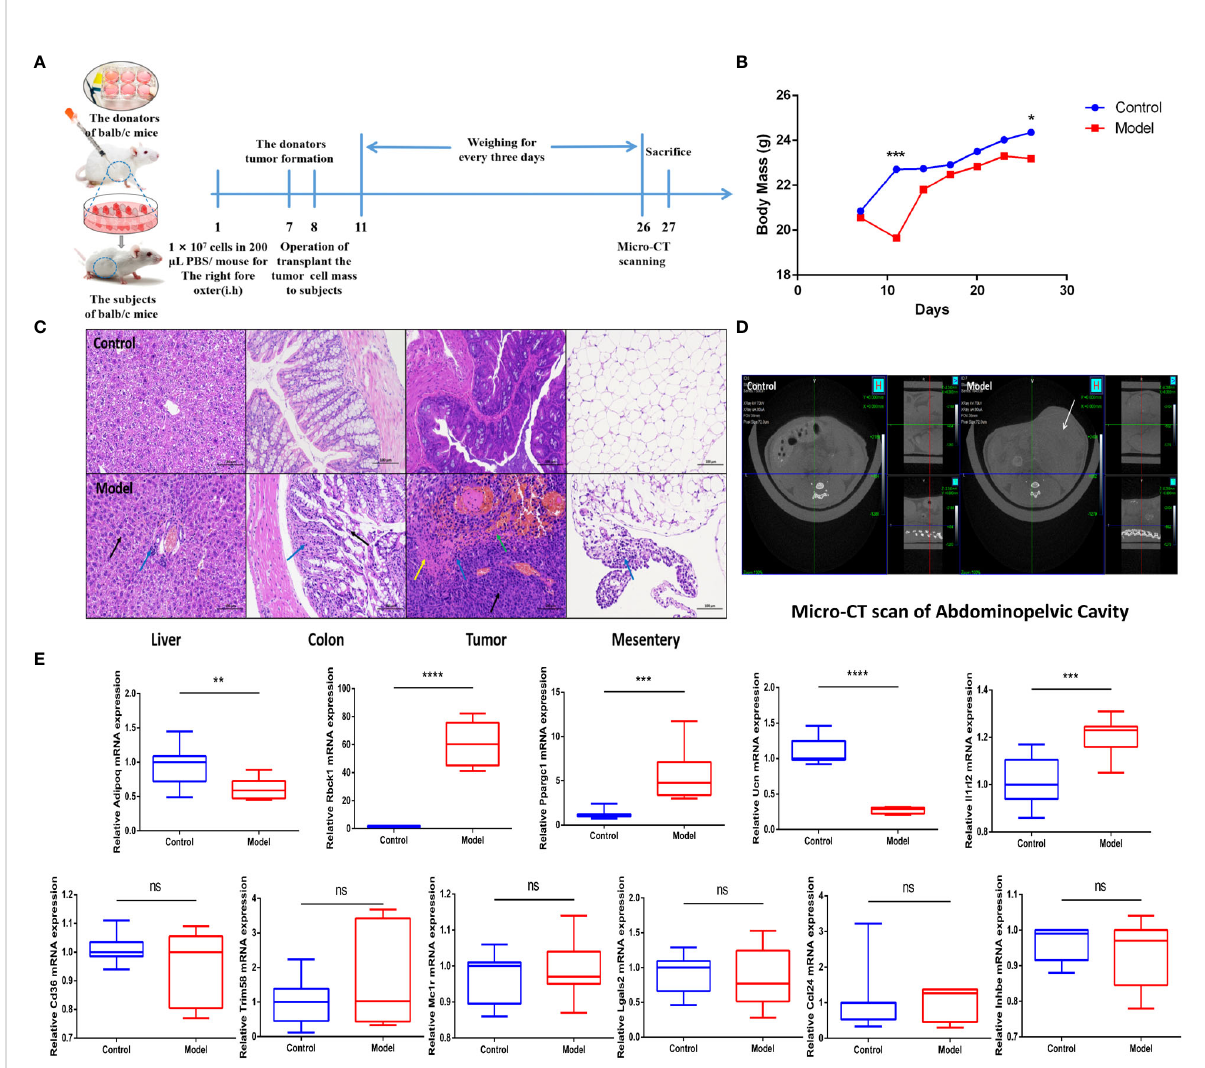
FIGURE 5 IRGPI gene expression situation in the identi fi ed murine CRC model. (A) Experimental scheme to establish the murine conlon transplant CRC metastasis model. (B) Curve of murine body mass change trends ( n = 10, * p < 0.05, *** p < 0.001). (C) In fl ammatory changes within liver, colon, tumor, and mesentery were measured by H&E staining (scale bar = 100 m m; the blue arrow points to the in fl ammatory cell in fi ltration; the black arrow points to the cellular damage; the yellow arrow points to the tumor cells nuclear abnormalities and cytoplasm eosinophilic; the green arrow points to the necrosis and hemorrhage). (D) Micro-CT scan images of abdominal cavity between control and model groups (the white arrow points to the tumor in abdominal cavity). (E) Relative IRGPI gene expression detection by RT-PCR between control and model groups. (Values are presented as 2 DD CT mean ± SEM, n = 3 replicates per group, ns: not signi fi cant, * p < 0.05, ** p < 0.01, *** p < 0.001, **** p <